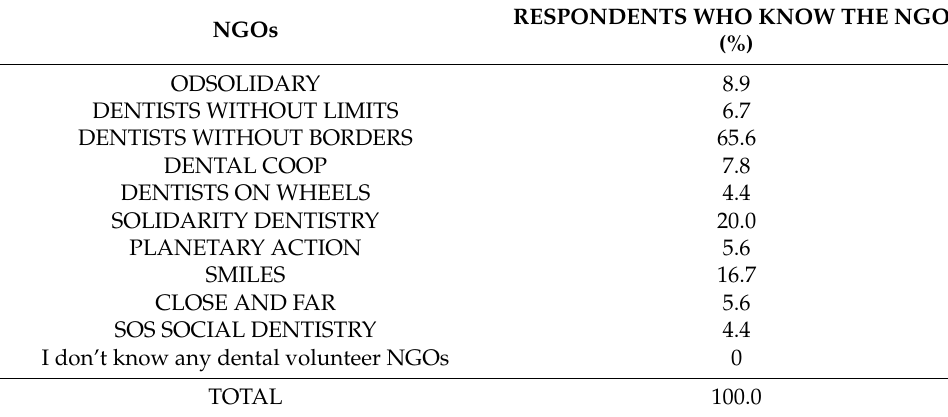
Table 5. Percentage of respondents who know the NGOs.